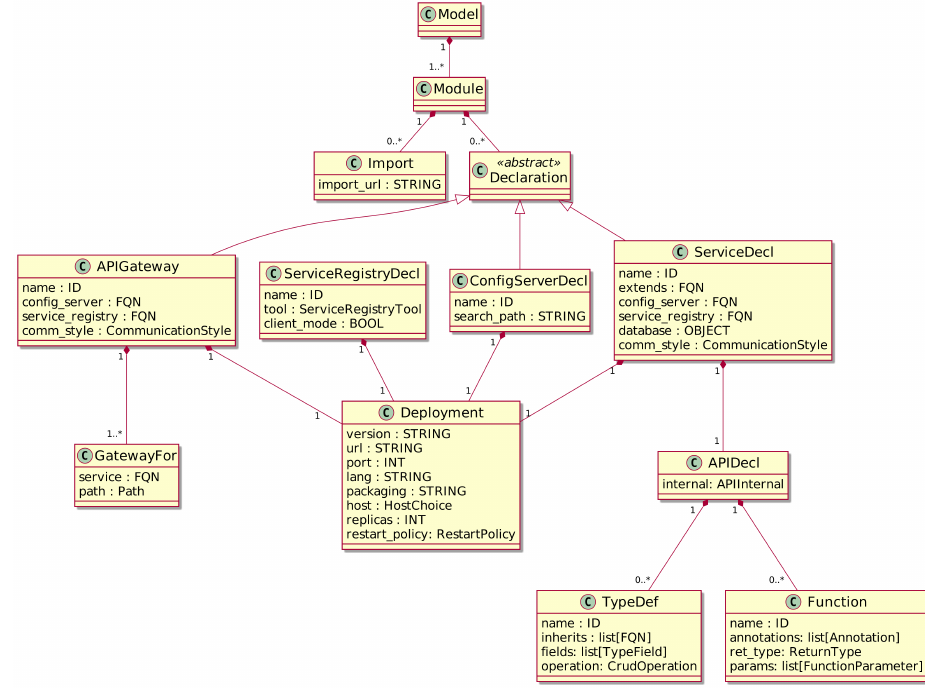
Figure 1. The simplified version of the Silvera metamodel (part 1).